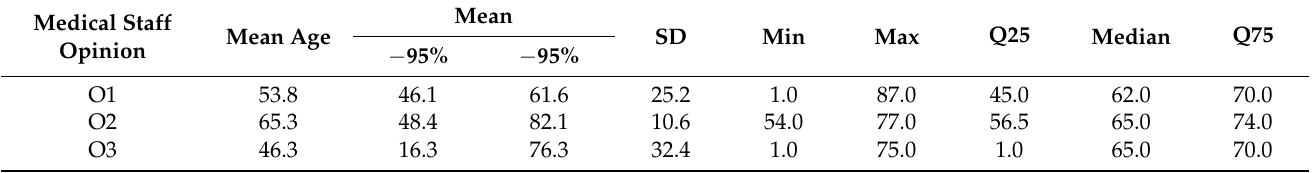
Table 5. Statistical indicators of patients’ age according to the perception of the utility of CPR.